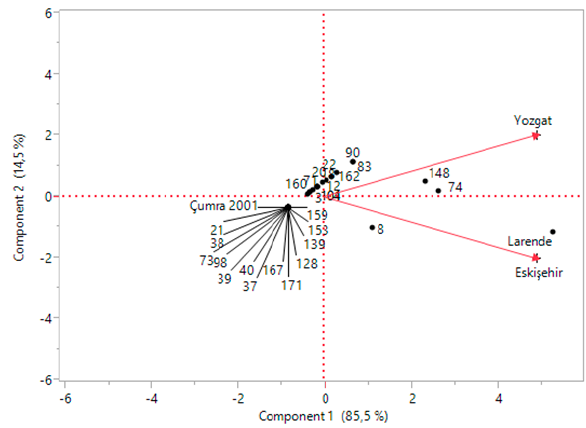
Figure 1. Biplot based on PCA analysis of the mean disease inci- dences of wild barley ( H. spontaneum ) genotypes inoculated with two isolates of Drechslera graminea